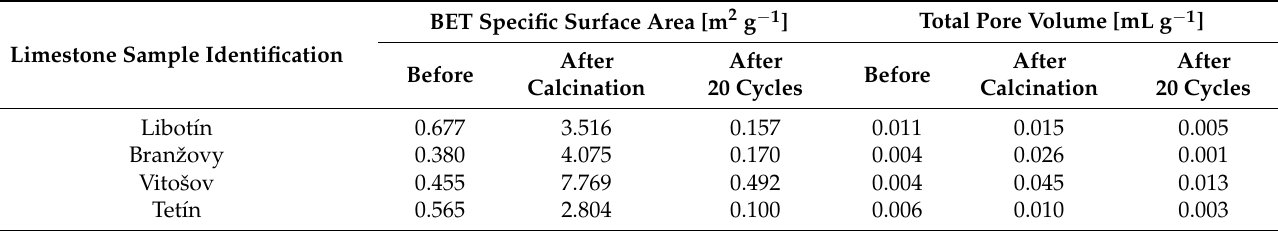
Table 2. Comparison of specific surface area and pore volume.